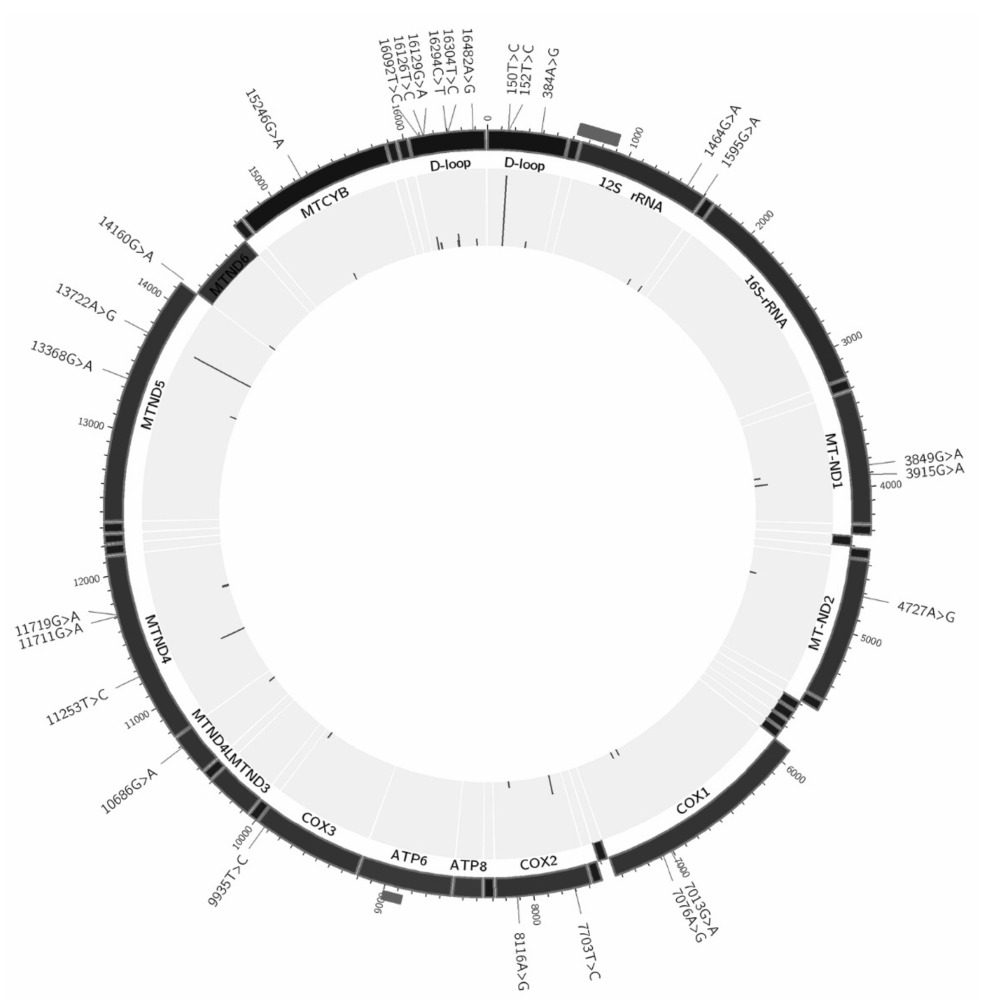
Figure 3. MtDNA map of heteroplasmic variants found in the study. Dark grey rectangles outside mark overlapping mtDNA fragments during mtDNA enrichment at positions 623–893 and 8767–9001; none of detected variants were located within these